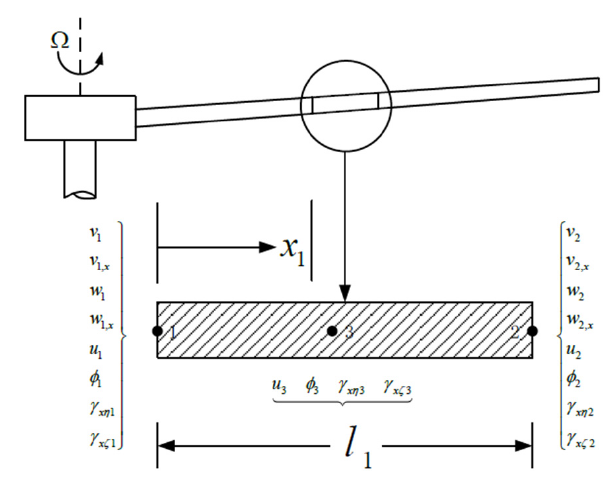
Figure 3. Degrees of freedom of the Timoshenko beam.